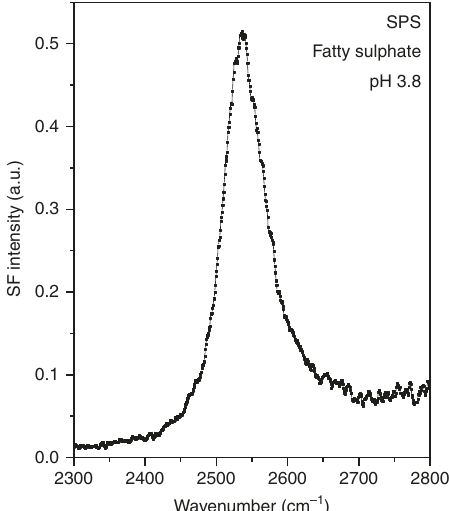
Fig. 4 Hydrated protons at a negatively charged fatty sulfate interface. VSF spectrum collected under the SPS polarization combination of a sodium eicosyl sulfate monolayer on a pH 3.8 HCl solution at a constant surface pressure of 2.5 mN m − 1 (area per molecule ~65 Å 2 ). Temperature 22 °C. The spectral feature assigned to the hydrated Eigen proton